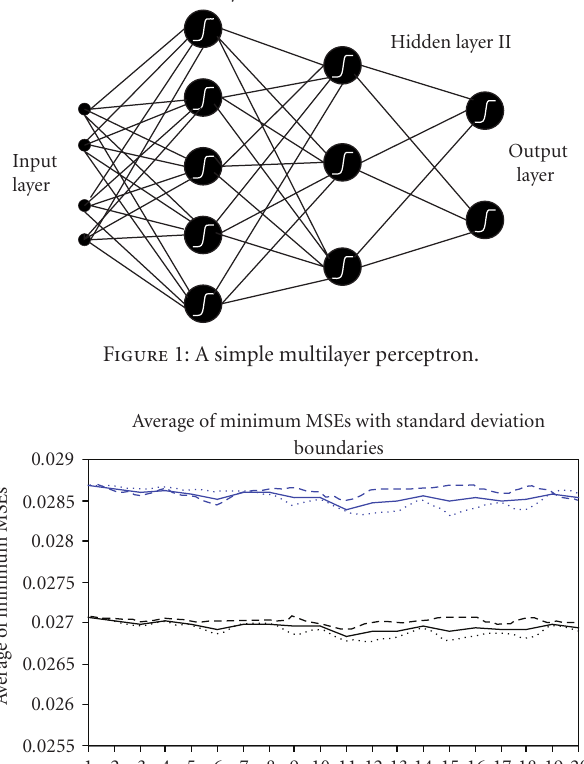
Table 2: Variable parameters of MLP NN model.